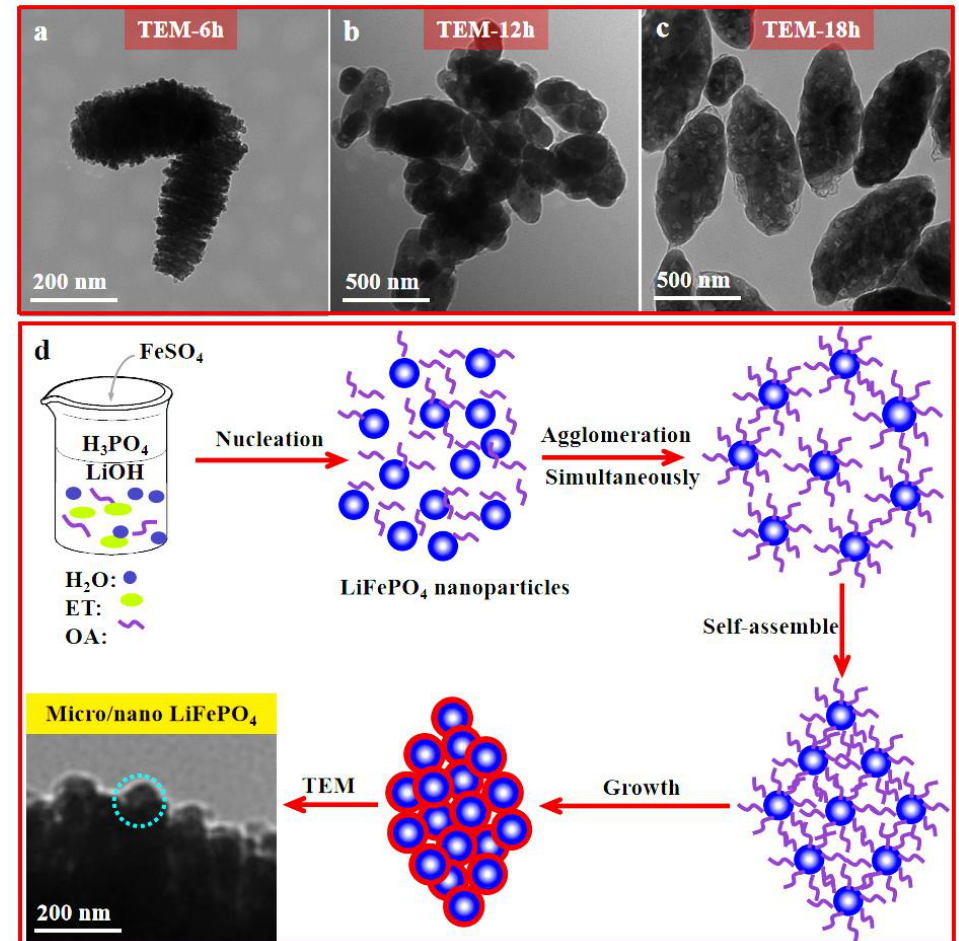
Figure 3. TEM images of LiFePO 4 microspheres with OA at 6 h ( a ), 12 h ( b ), 18 h ( c ) and the schematic illustration of formation mechanism of the grape-like LiFePO 4 microsphere ( d ).